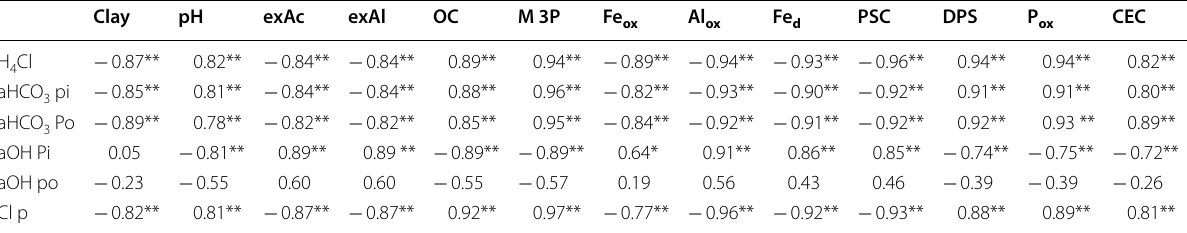
Table 9 Correlation table for fractions of P and some soil properties